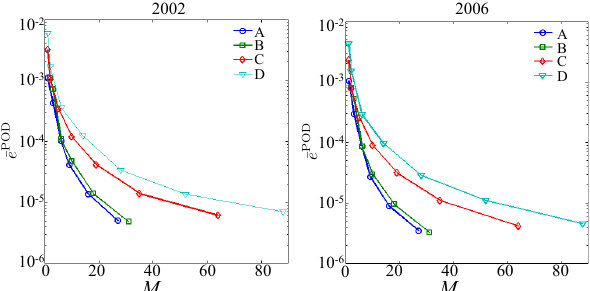
Figure 2. Variation of the mean POD error ( ¯ e POD ) , with respect to number of bases ( M) , in year 2002 and 2006 for single-site ROM constructed using the POD method.